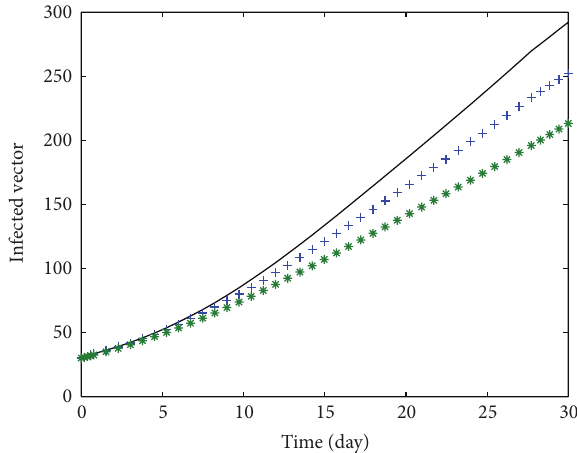
Figure 7: Infected human: solid line 𝛼 = 1.0 , ++ line (𝛼 = 0.95) , and ∗∗ line (𝛼 = 0.90) .